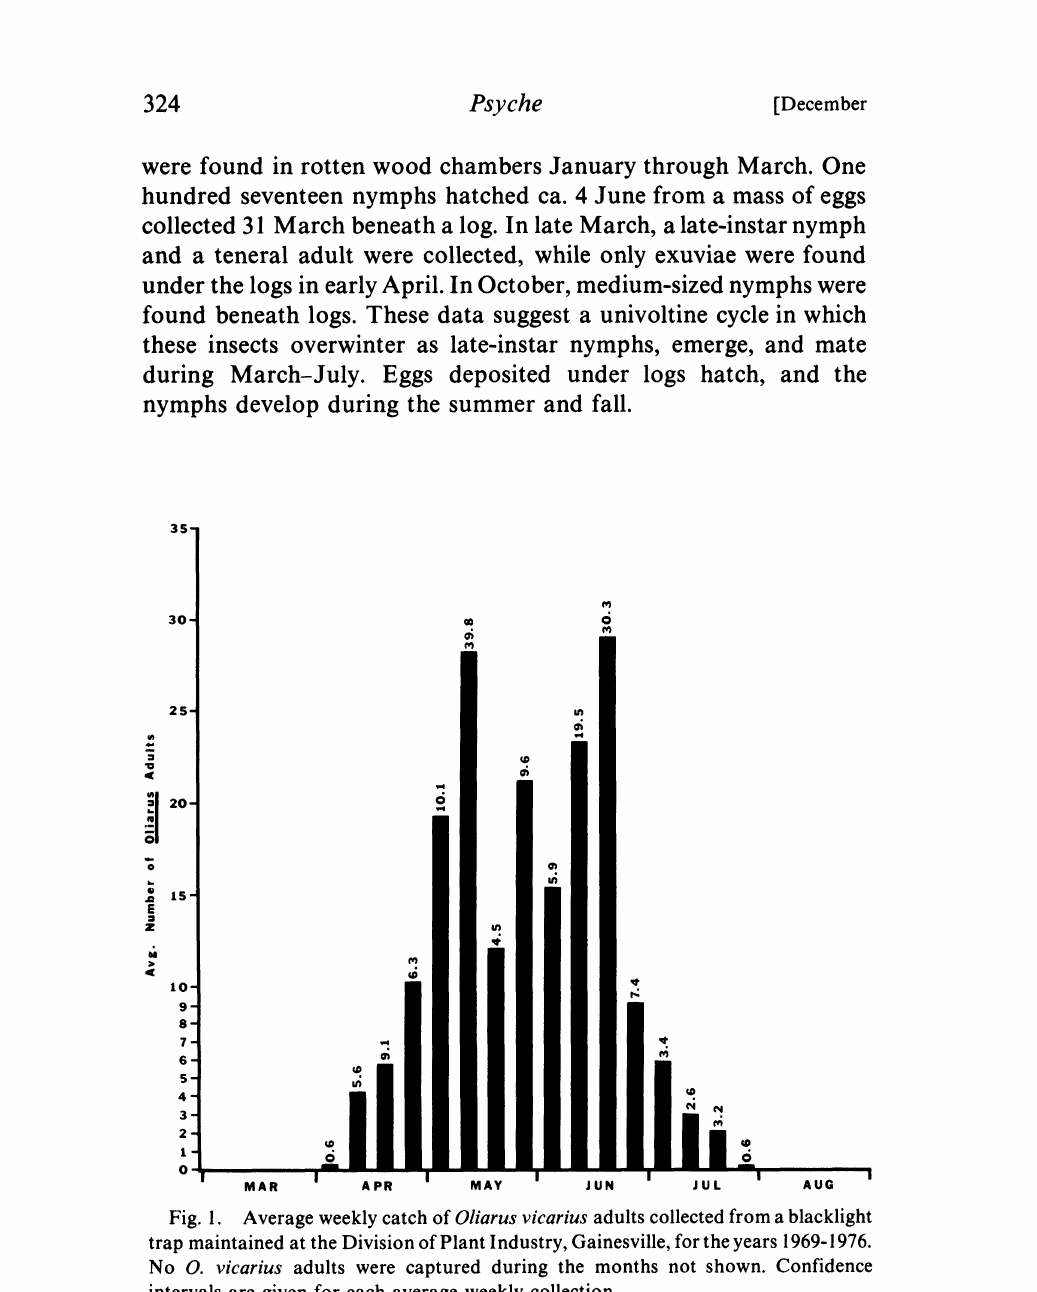
Fig. I. Average weekly catch of Oliarus vicarius adults collected from a blacklight trap maintained at the Division ofPlant Industry, Gainesville, for the years 1969-1976. No O. vicarius adults were captured during the months not shown. Confidence intervals are given for each average weekly